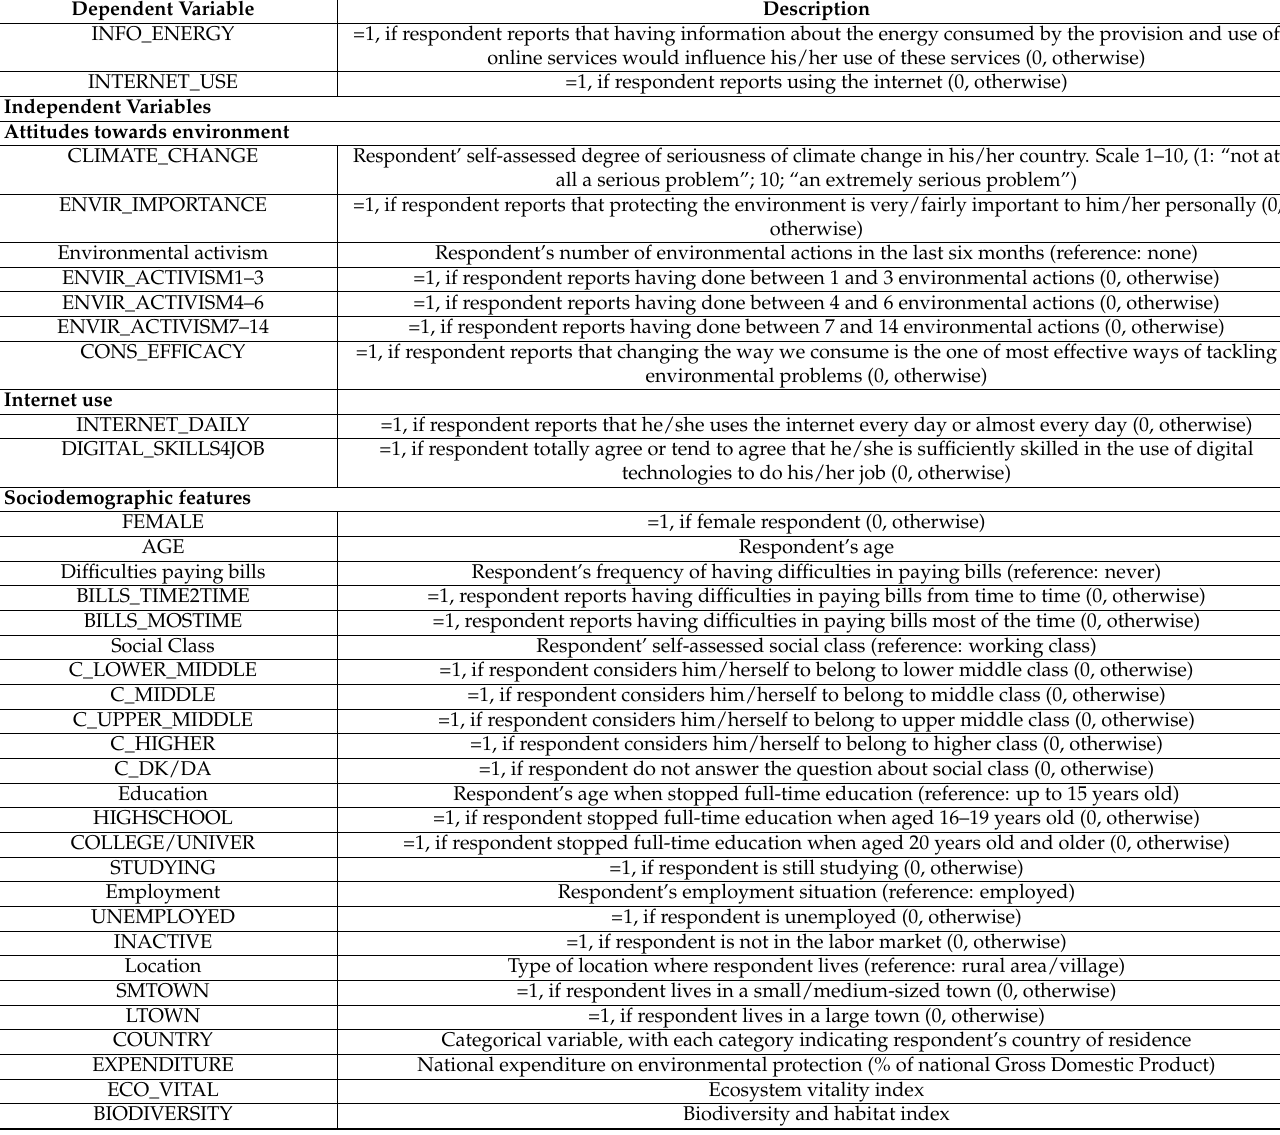
Table 1. Description of